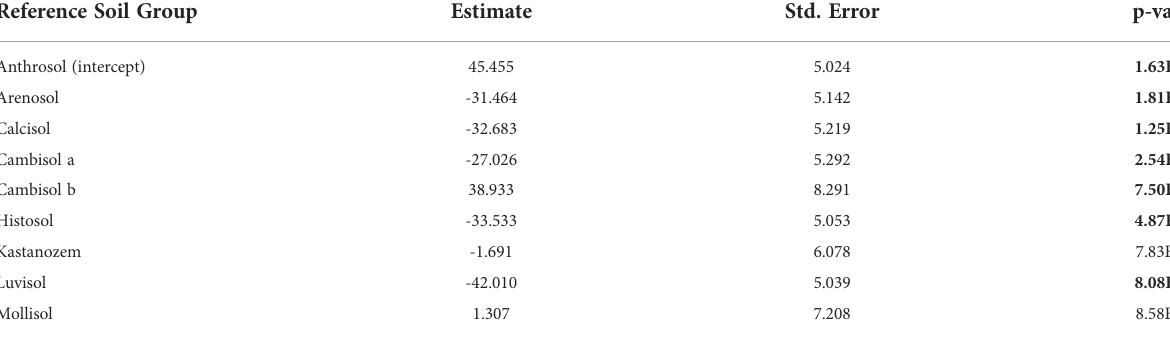
TABLE 3 Summary table of GLM predicting muramic acid (mg/g) by reference soil group. Reference Soil